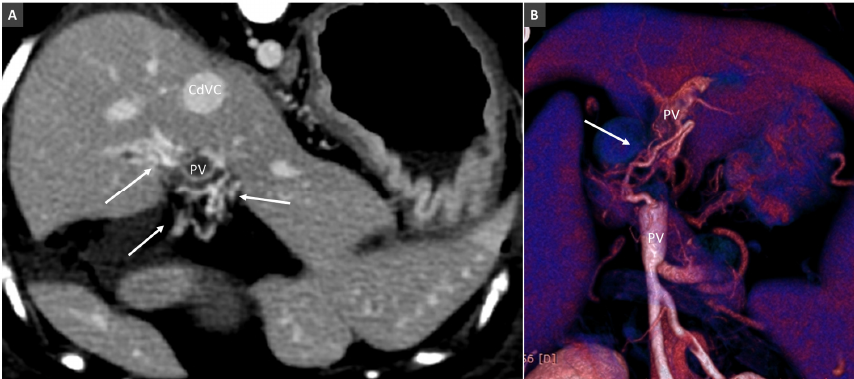
Figure 20. Porto-portal collaterals (cavernous transformation of PV) in a dog due to PV thrombosis. ( A ). Transverse view at the porta hepatis, showing multiple tortuous vessels surrounding the thrombosed PV (arrows). ( B ). Volume rendered image (ventral view) in another dog with extrahepatic PV thrombosis. Arrow indicates a porto-portal collateral bypassing the site of obstruction.